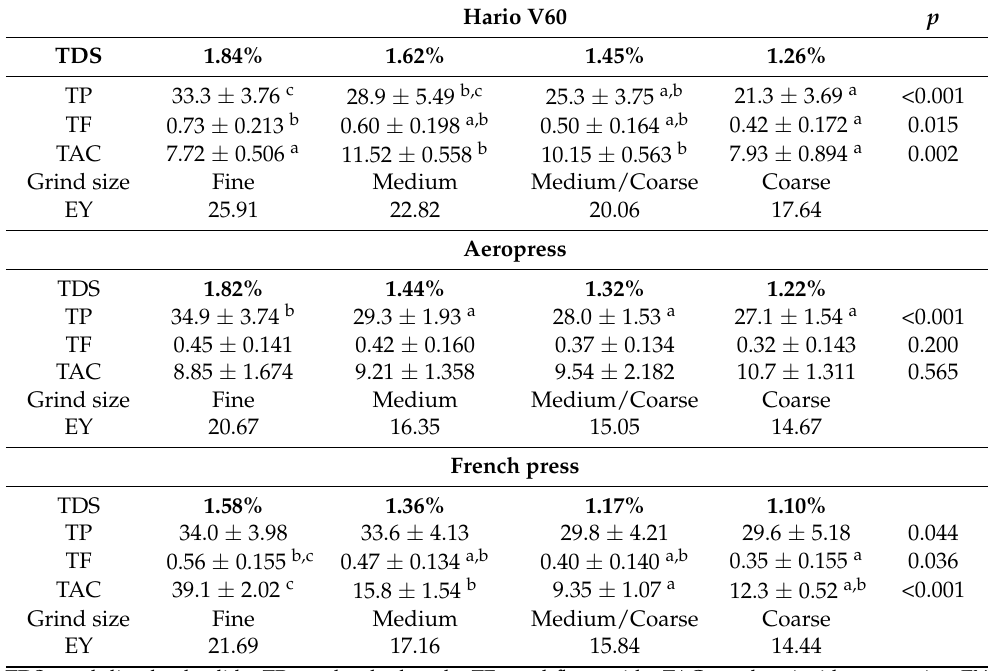
Table 1. Effect of TDS, grind size, and EY (%) on TP ( µ g GAE/mg), TF ( µ g QE/mg), and TAC ( µ g TE/mg) in specialty coffees prepared by different methods (means ± SDs, n = 7). Hario V60 p